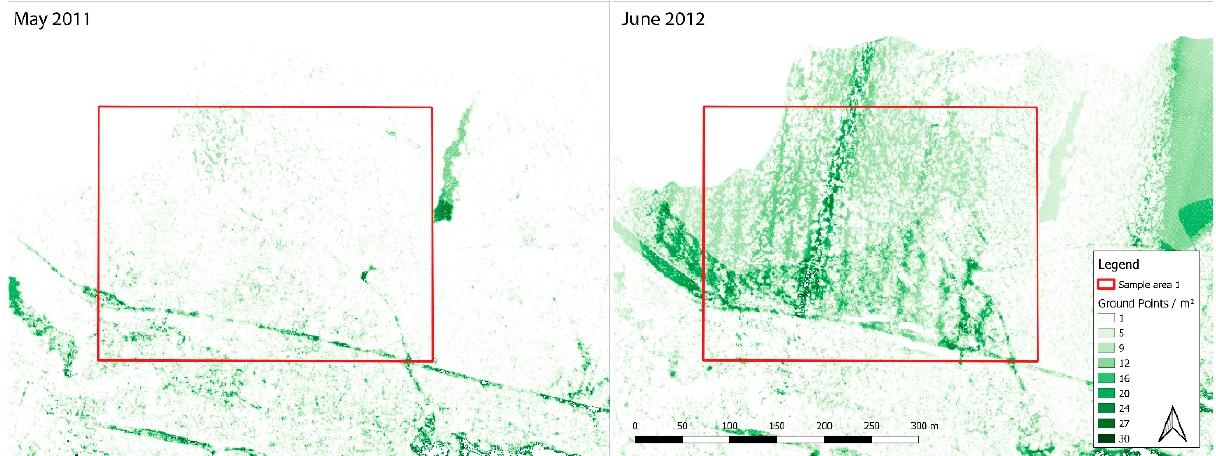
Figure 11. ( Left ): ratio of ground points and total points per m 2 from May 2011 indicating dense vegetation. ( Right ): the same area from June 2012 shows that due to forest management, north-south-oriented 5 m wide lines of trees had been removed. As a result, more ground points could be collected by ALS in the respective area, which is indicated by the darker green tones.